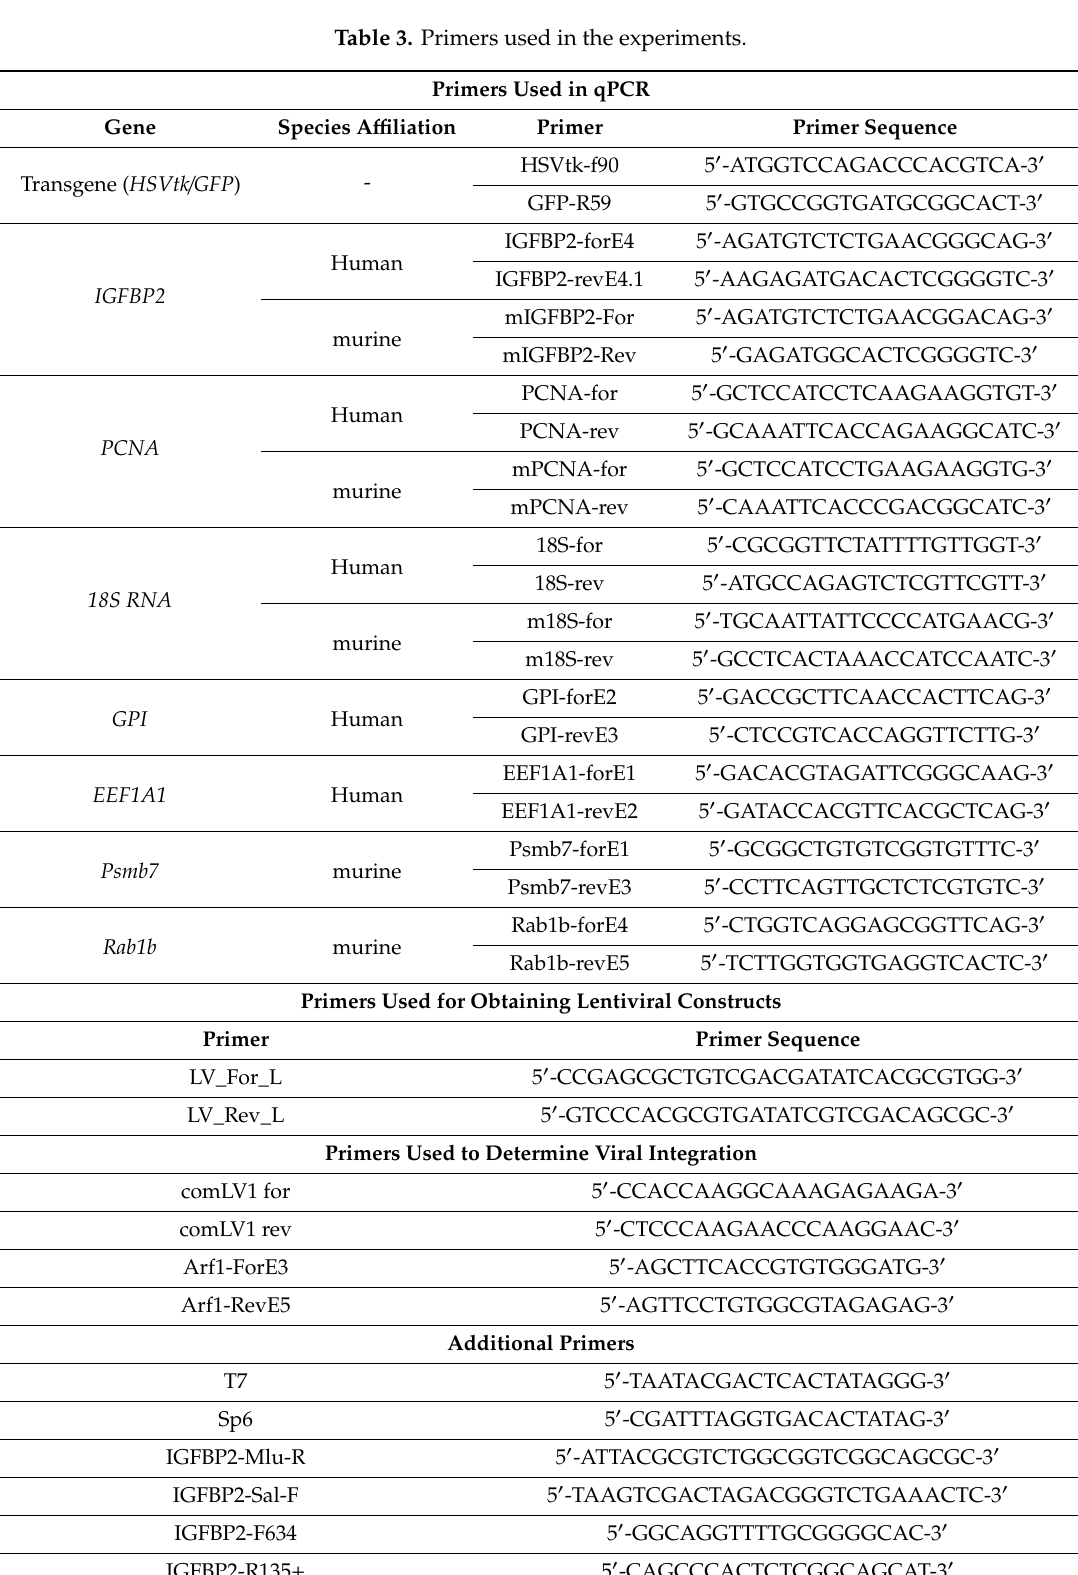
Table 3. Primers used in the